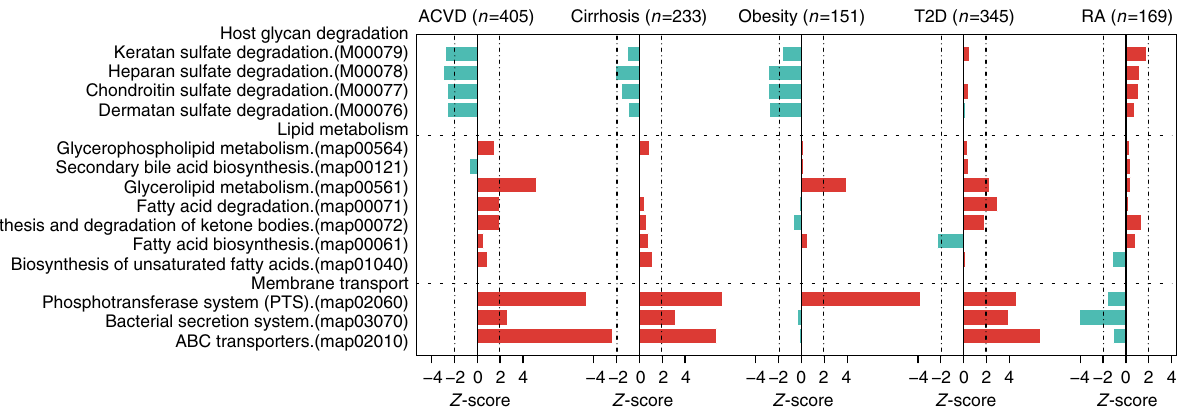
Fig. 7 Differential enrichment of membrane transport pathways, lipid metabolism pathways, and modules for host glycan degradation. X-axis represents reporter score. Red , case-enriched; cyan , control-enriched, compared within each disease cohort (ACVD, total n = 405 including 218 cases; Cirrhosis, total n = 231 including 120 cases; Obesity, total n = 151 including 72 cases; T2D, total n = 345 including 171 cases; RA, total n = 169 including 95 cases). Dashed lines indicate a reporter score of 1.96, corresponding to 95% con fi dence in a normal